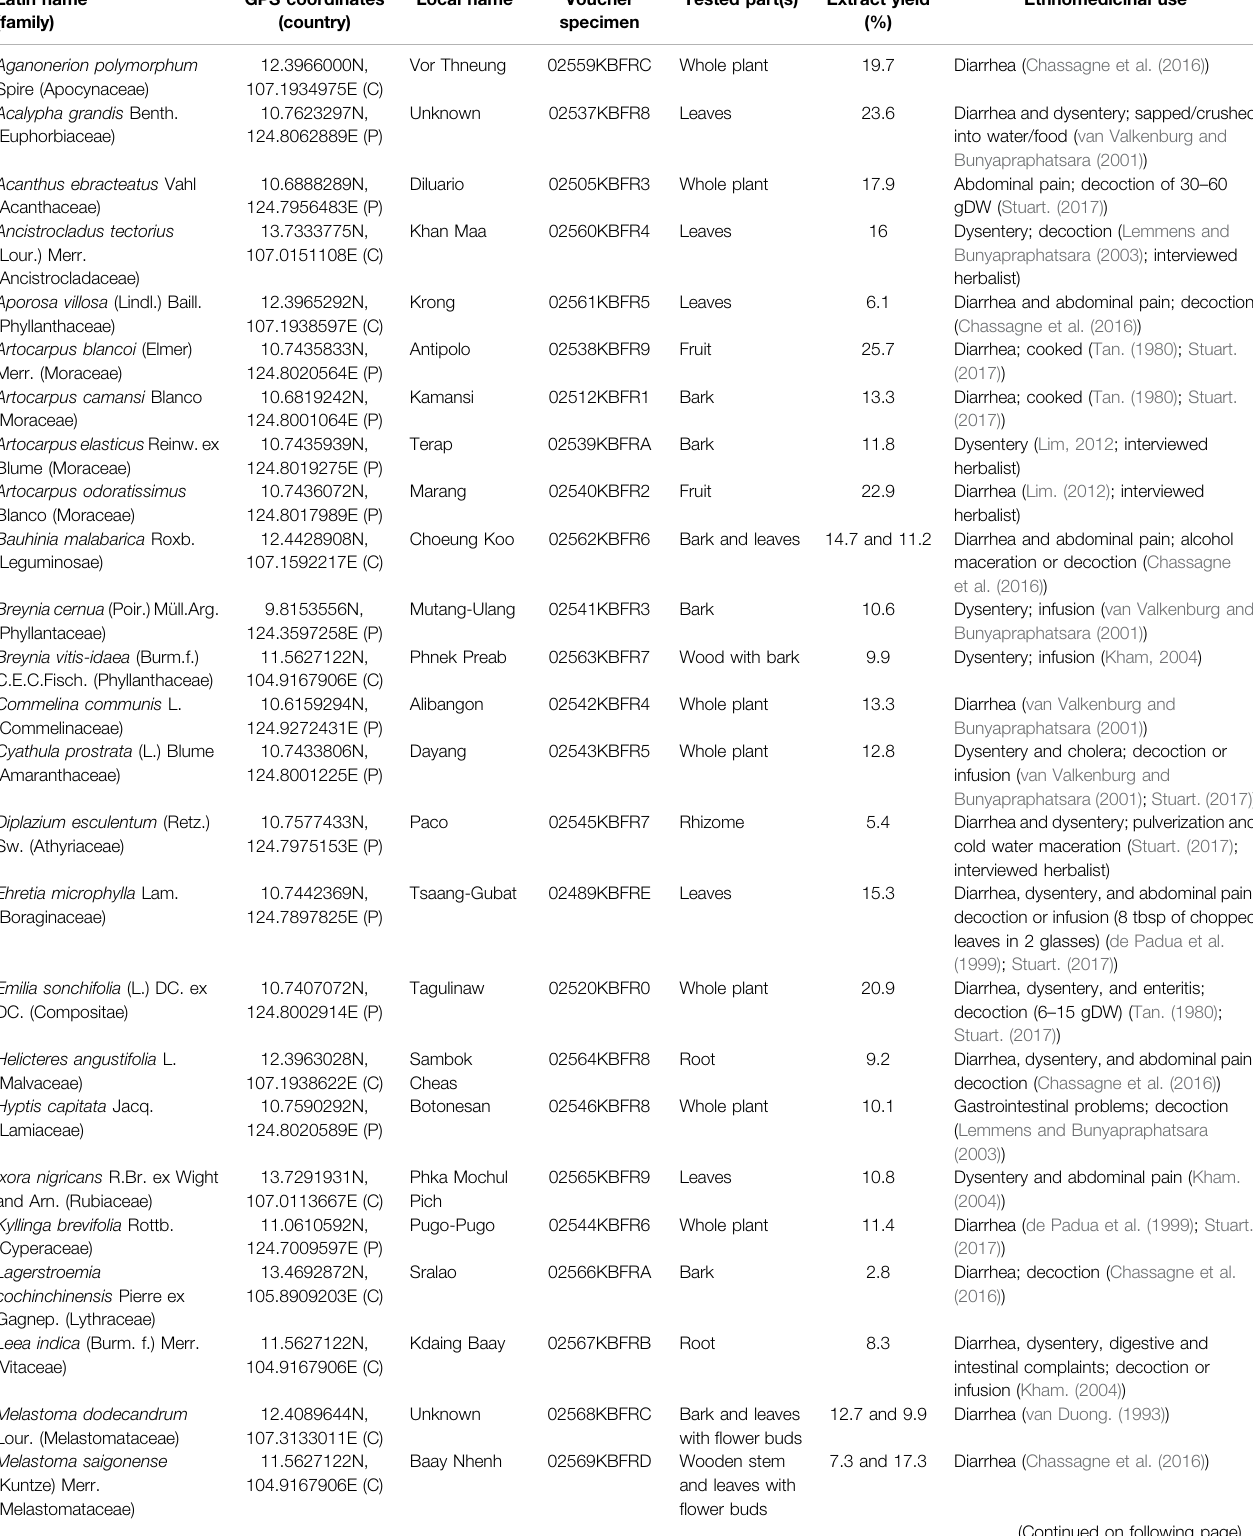
TABLE 1 | Ethnobotanical data on Cambodian and Philippine medicinal